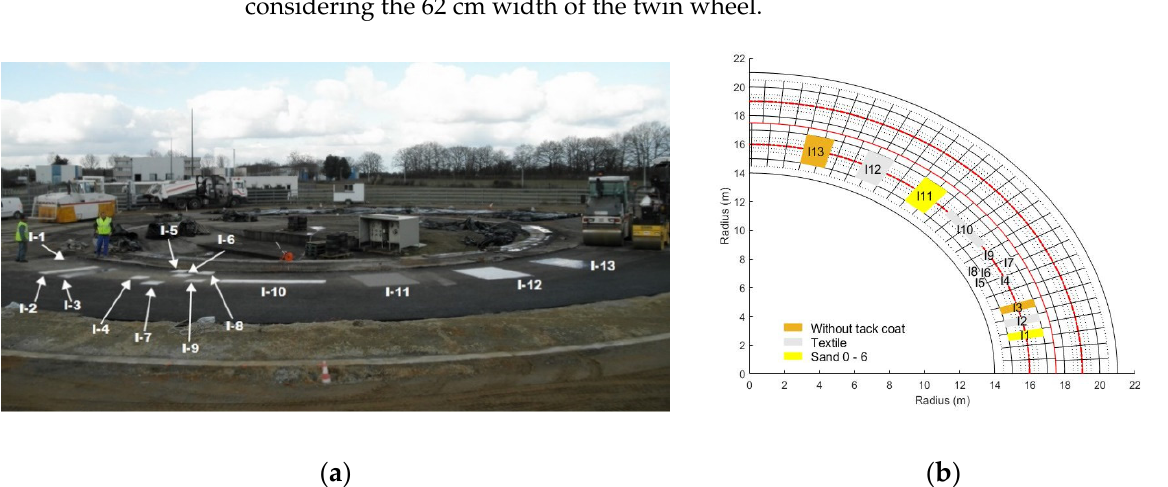
Remote Sens. 2021 , 13 , x FOR PEER REVIEW Figure 1. Test section, ( a ) with the defects made during construction, ( b ) in the form of a site plan. Table 1. Characteristics of the artificial defects along the test track.